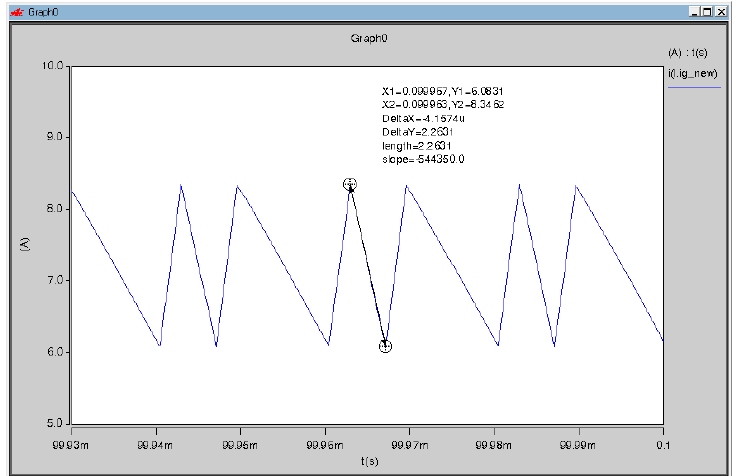
Figure 19. Zoom in the input current ripple for the proposed strategy when G = 6 . 5, D = 0 . 7921 ( k d = 0 . 5778).